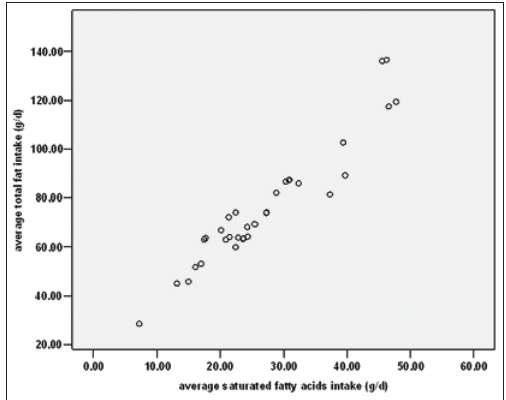
FIGURE 6. Link between SFAs and total fat intake in female